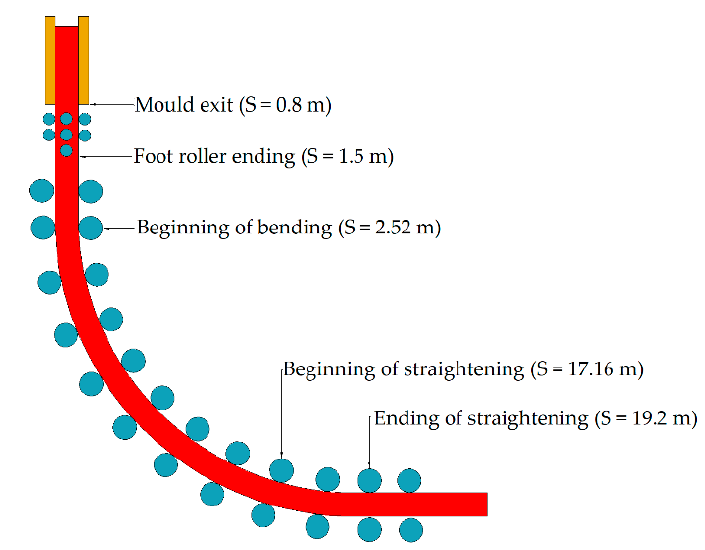
Figure 4. Schematic drawing of key characteristic positions. Table 2. Thermophysical properties of S355 steel used in the study.